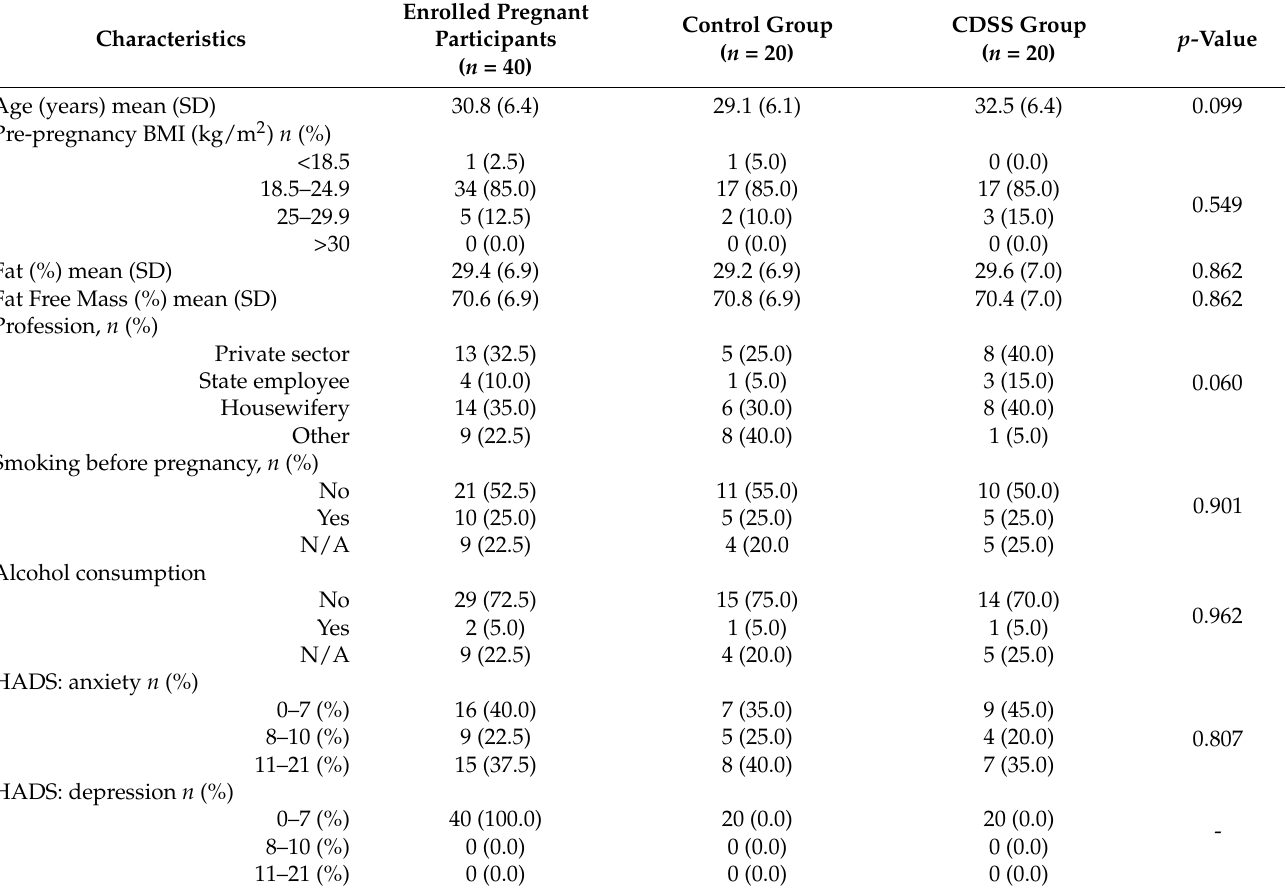
Table 2. Baseline characteristics of the